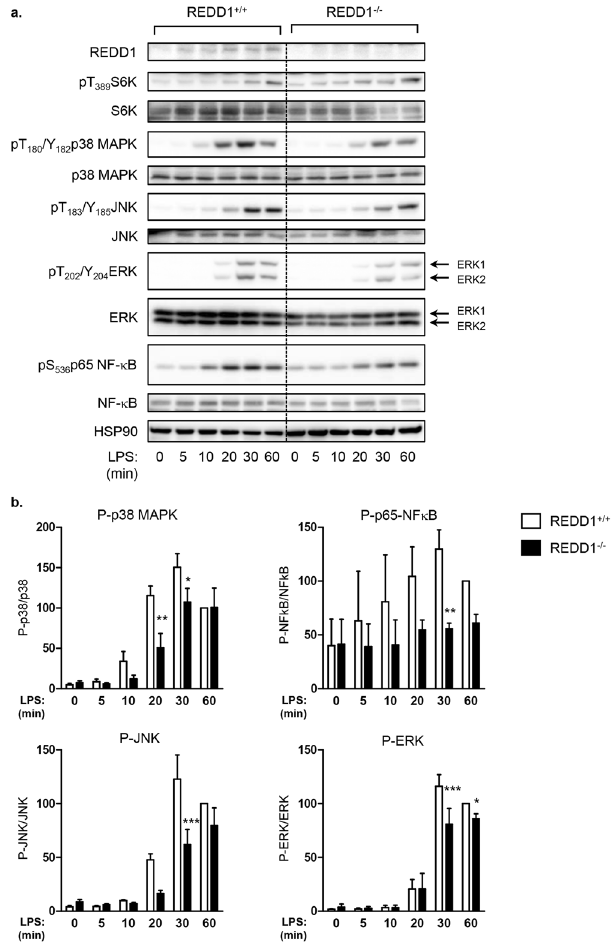
Figure 4. Activation of p38 MAPK, JNK and NF- κ B was impaired in REDD1 − / − BMDM in response to LPS. REDD1 + / + and REDD1 − / − BMDM were stimulated with LPS (100 ng/ml) for indicated periods of time. Cell lysates were analyzed by immunoblots with indicated antibodies. ( a , b ) Quantification of phosphorylated proteins is shown with the value of REDD1 + / + treated with LPS for 60 min taken as 100 (n = 3 independent experiments, * p < 0.05; ** p < 0.01, *** p <